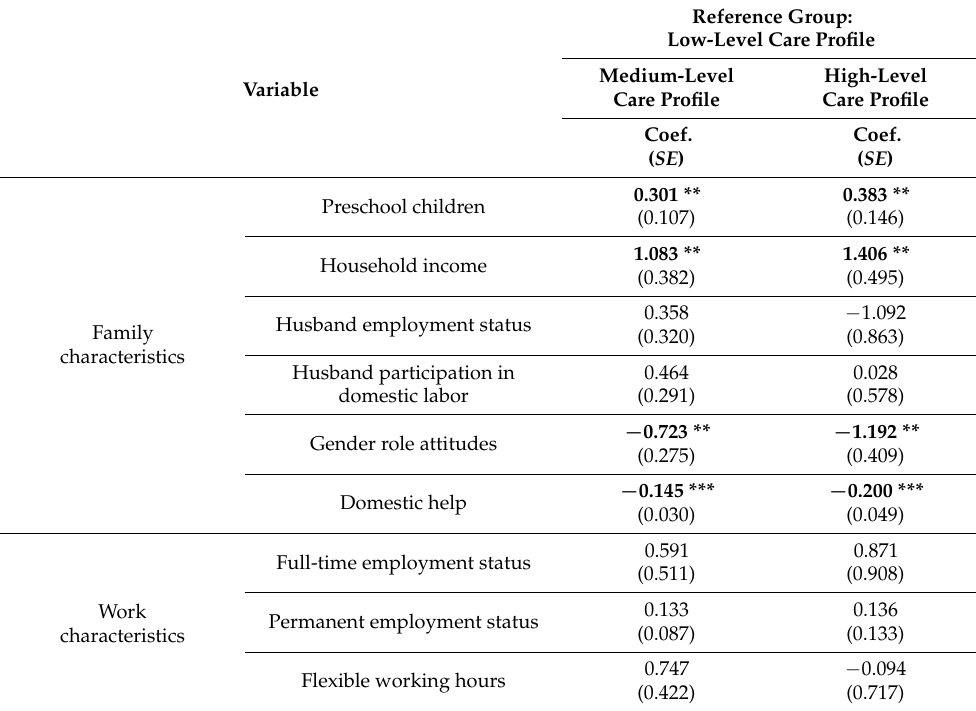
Table 5. Multinomial logistic regression results for predicting profile